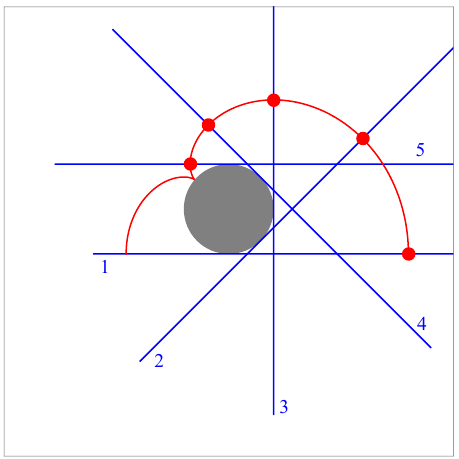
Figure 1 . To draw curves, Leo rolls a ruler without slipping around a (cid:12)xed wheel while allowing the pen to be pushed by the ruler. In this picture, Leo has kept the pen still with respect to the ruler. The curve is drawn for a full rotation cycle, though we have included only (cid:12)ve positions of the ruler to avoid overcrowding the